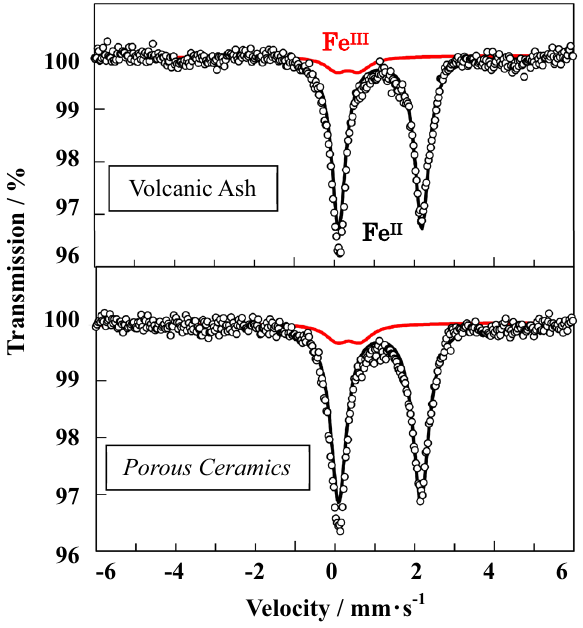
Fig. 3 RT- 57 Fe Mo¨ssbauer spectrum of volcanic ash ( top ) and that of porous ceramics prepared by sintering thoroughly pulverized mixture of volcanic ash and waste glass (5:2) with an extra amount (5 mass%) of wood charcoal ( bottom